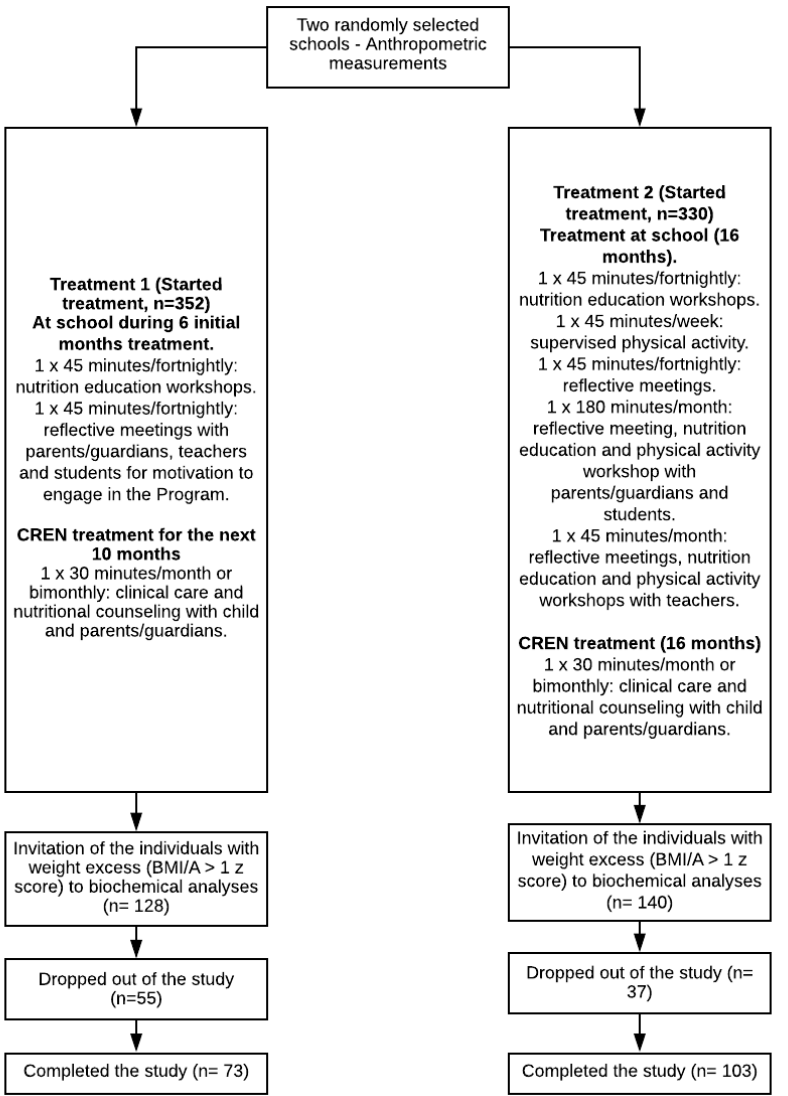
Figure 1. Flowchart of the study design. CREN, Centre for Nutritional Recovery and Education.